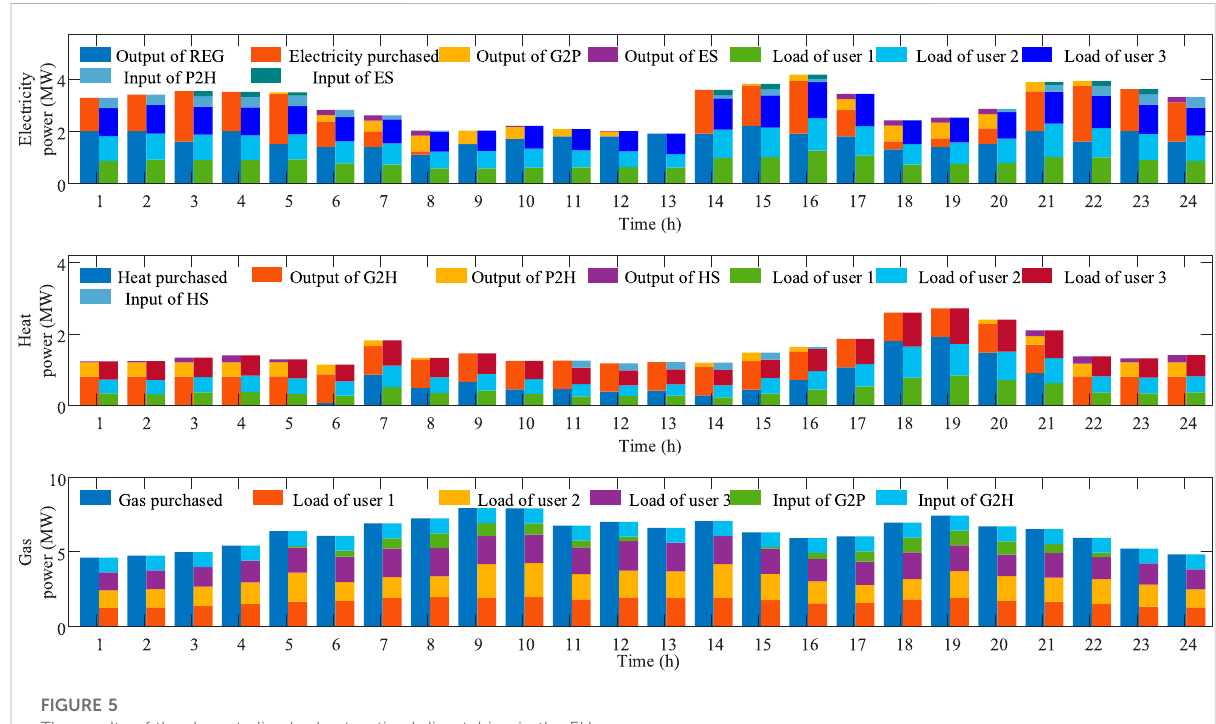
FIGURE 5 The results of the decentralized robust optimal dispatching in the